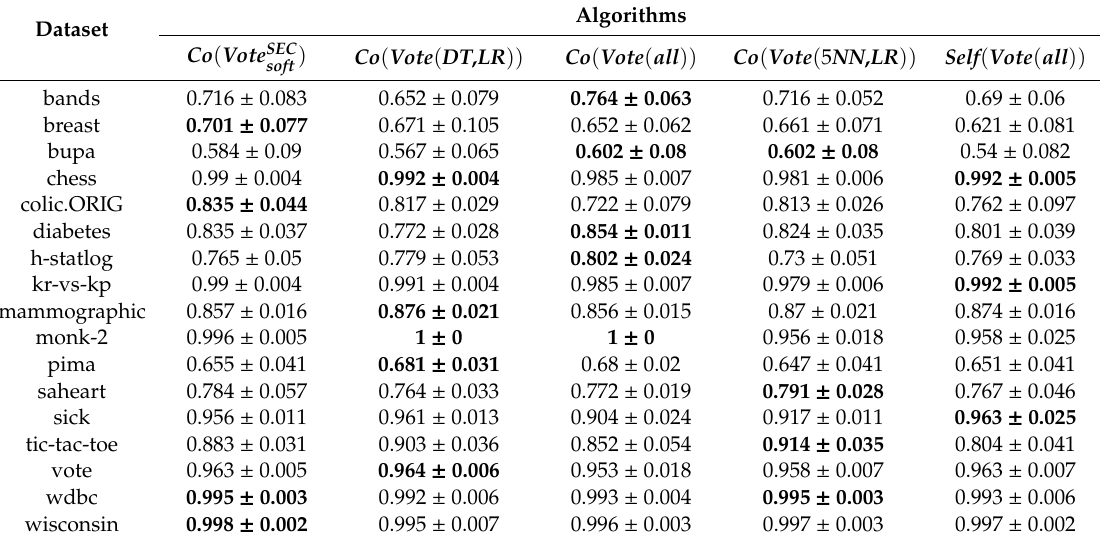
Table 5. Classification accuracy ( ± stdev) values for the best five variants (labeled ratio